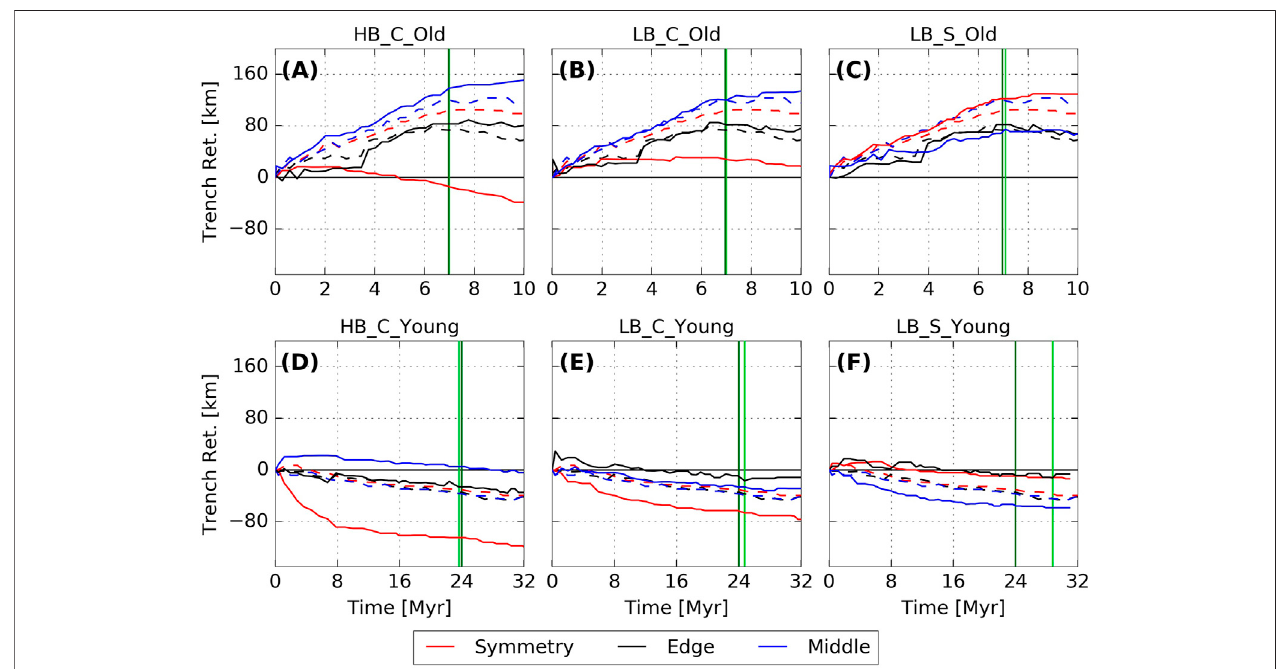
FIGURE5| Trenchmotionevolutionforoldplatemodelsinpanels (A – C) andyoungplatemodelsinpanels (D – F) ,atthelocationsmarkedon Figure3 .Linesstyles are asin Figure4 , i.e., solidlines are forthe ridgemodels, and dashed lines for thecorrespondingreferencecases. Vertical lines mark t 660for theridge (light green) and no-ridge (dark green) cases. The initial location of the trench, i.e. 0 km, is marked with solid black horizontal lines.